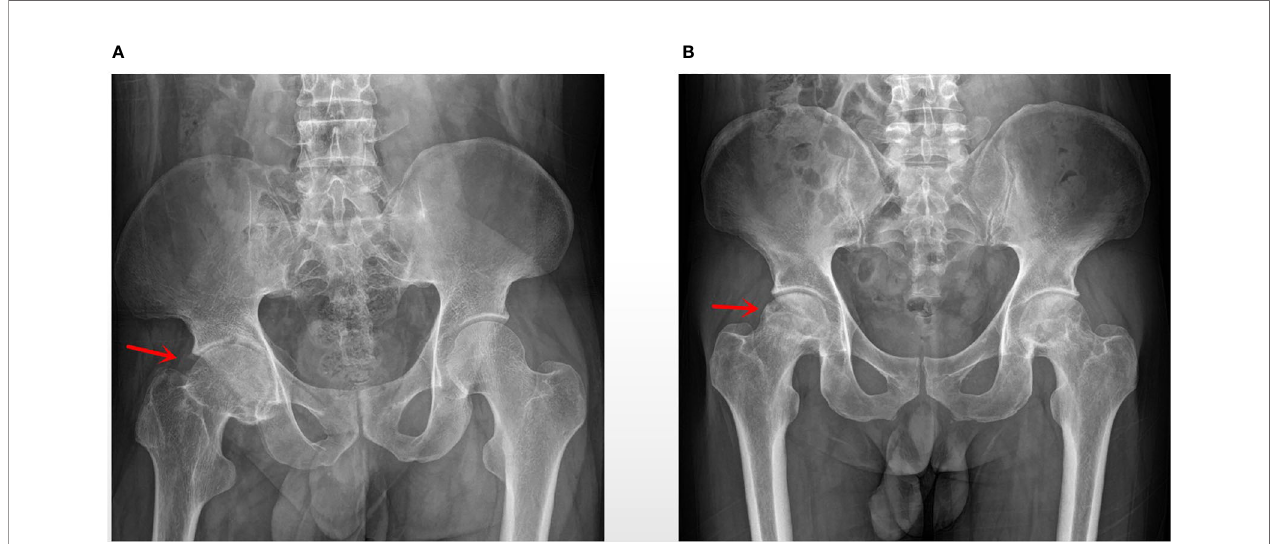
FIGURE 1 | (A) AS group: a patient with AS, 28 years old, male, BMI: 15.34, ESR: 41 mm/h, HLA-B27 (+); (B) No-AS group: a patient with aseptic femoral head necrosis, 43 years old, male, BMI: 24.564, ESR: 63